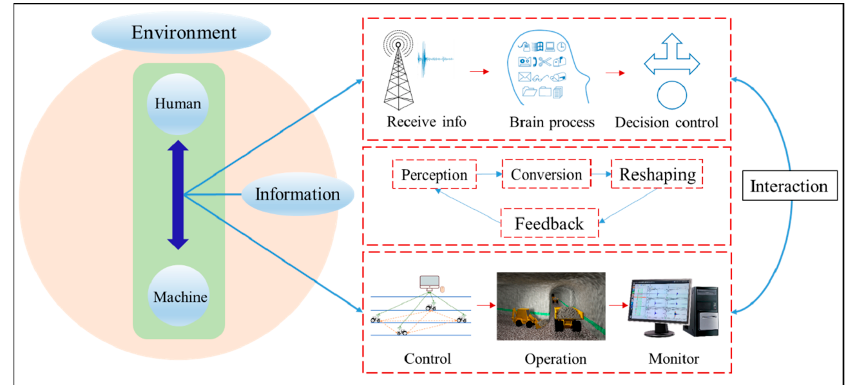
Figure 8. Research object of ISE. After receiving the information, humans use their brains to process original information to make safety decisions. Through interaction between humans and machines, intelligent control of the machines is realized, and results will be presented on the display.